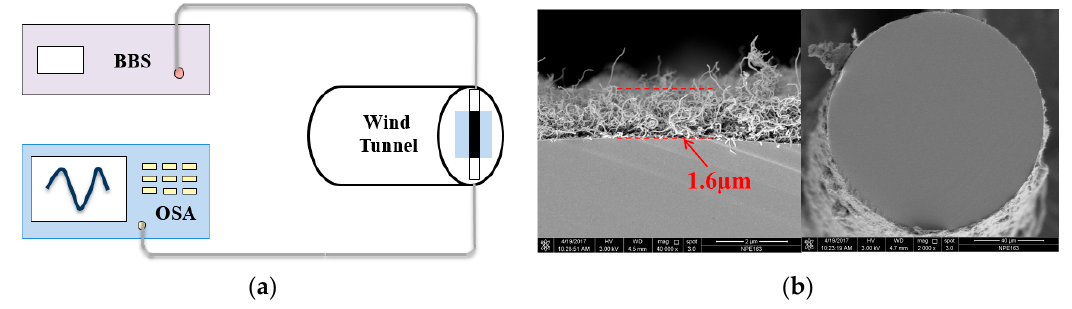
Figure 2. ( a ) Wind speed sensing system with only a BBS and a wavelength demodulation device. ( b ) SEM images of the SWCNT film on the fiber surface. The thickness of the film is 1.6 μ m with 50 dipping cycles.